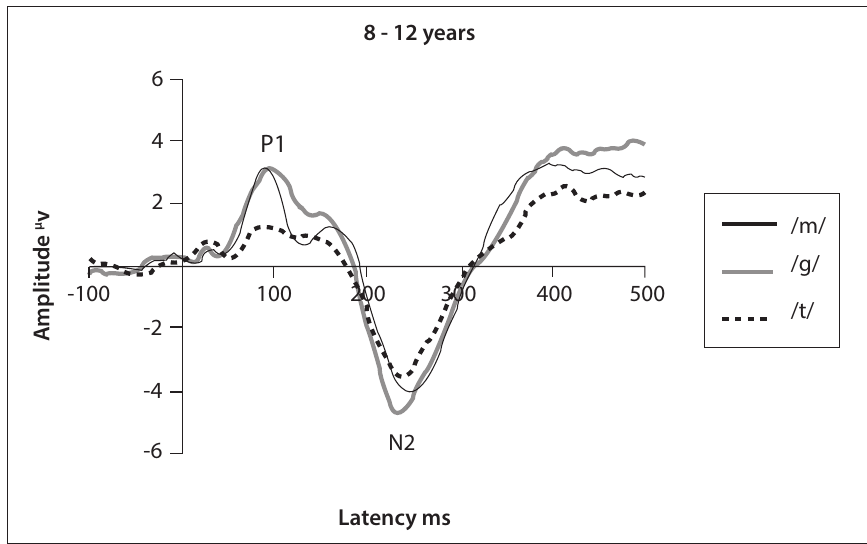
Fig. 3. Grand averaged CAEP waveforms in response to the three speech stimuli in the 8 - 12-year age